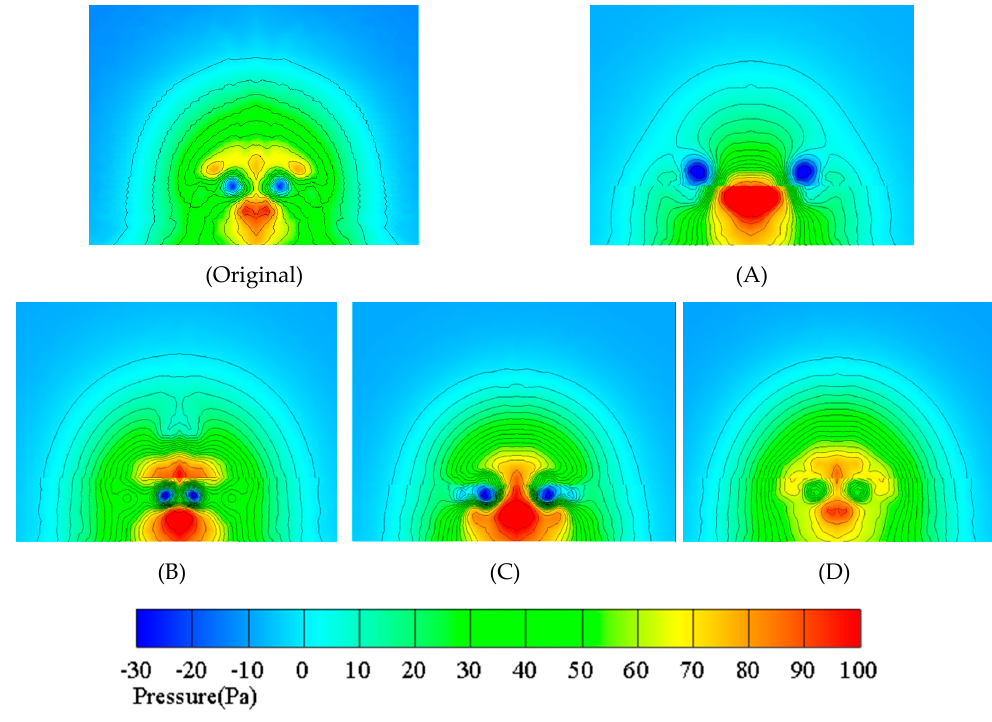
Figure 12. Pressure contour on x = 0.6 m section (15 kV).